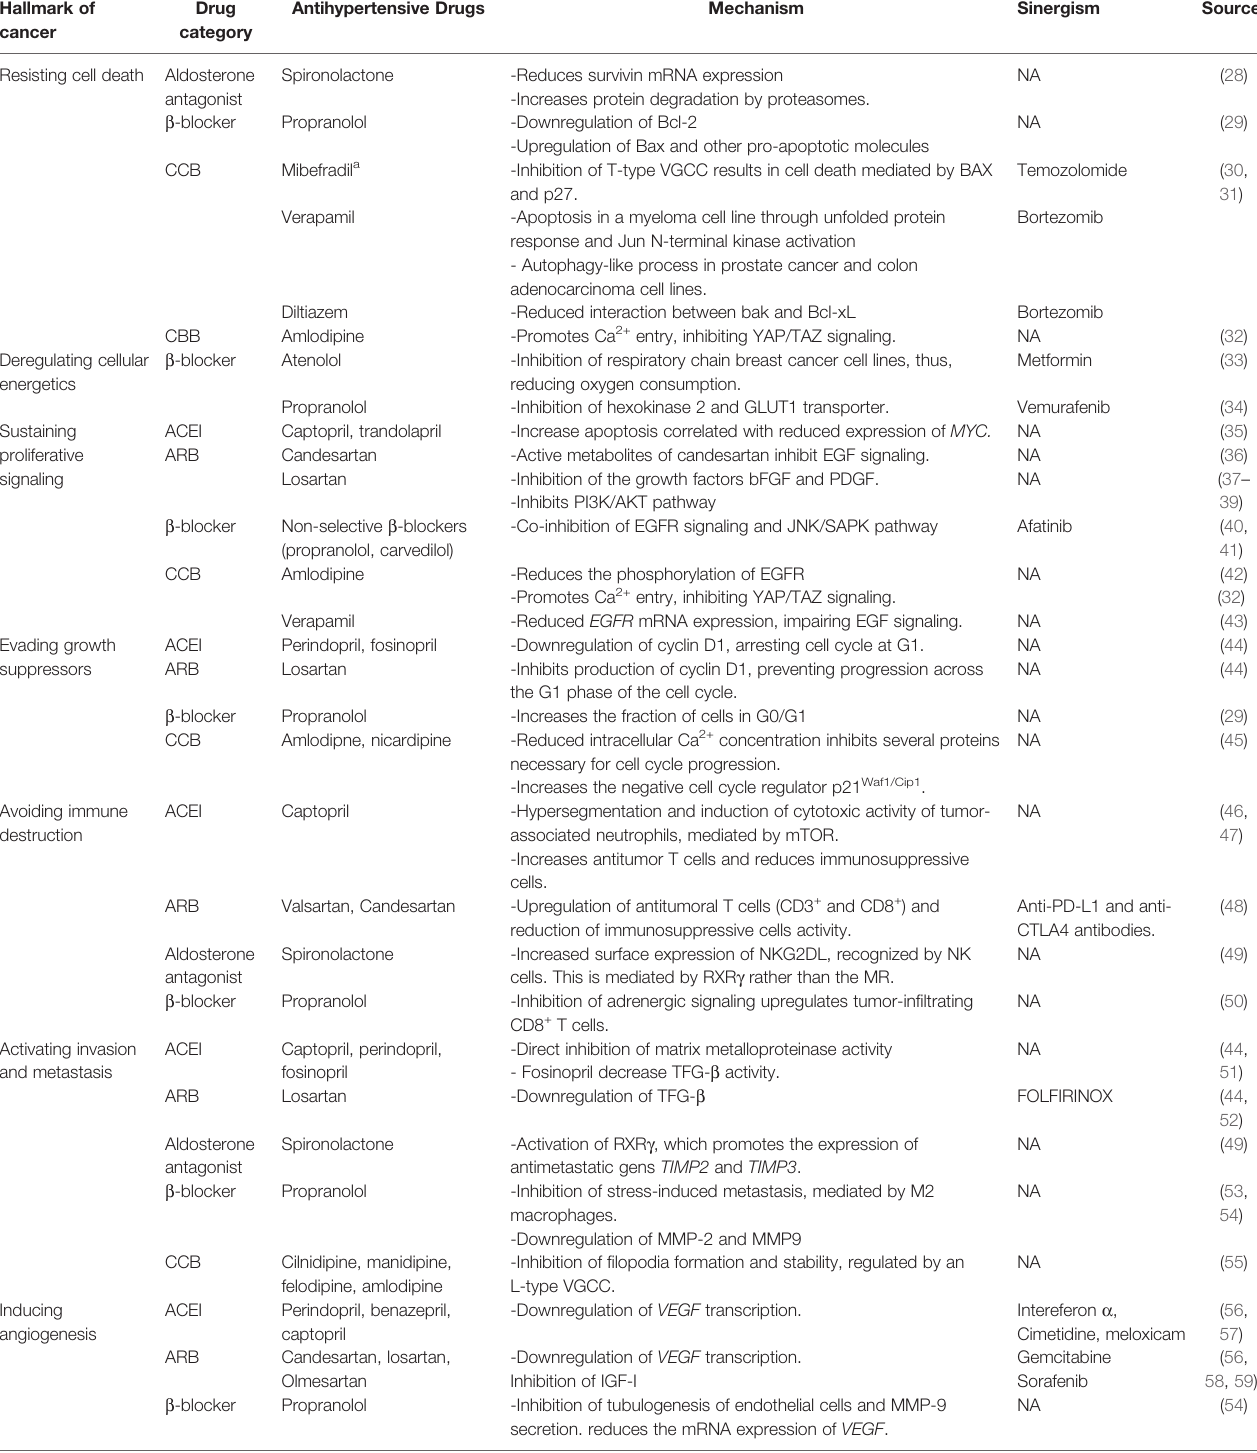
TABLE 1 | Hallmarks of cancer affected by antihypertensive drugs alone or in synergy with other drug in preclinical and clinical studies. Hallmark of